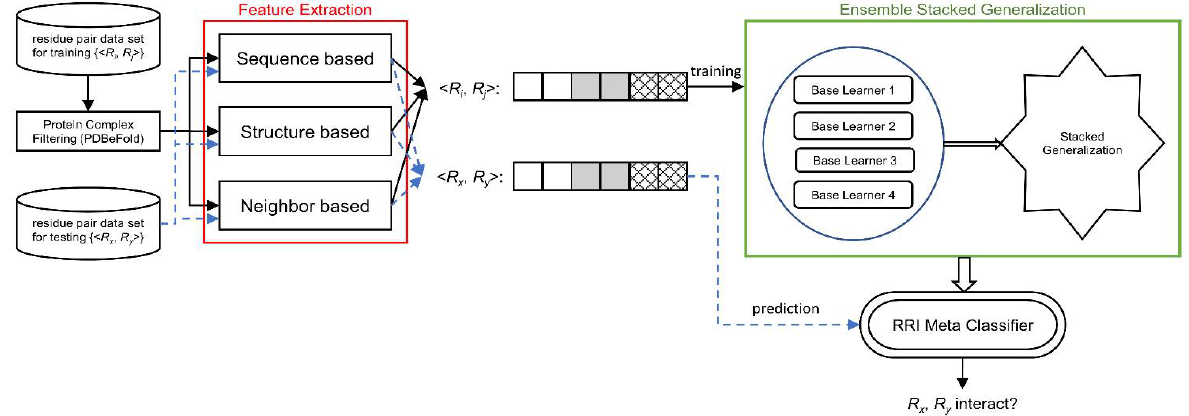
Figure 5. System Diagram of RRI-Meta for predicting residue–residue